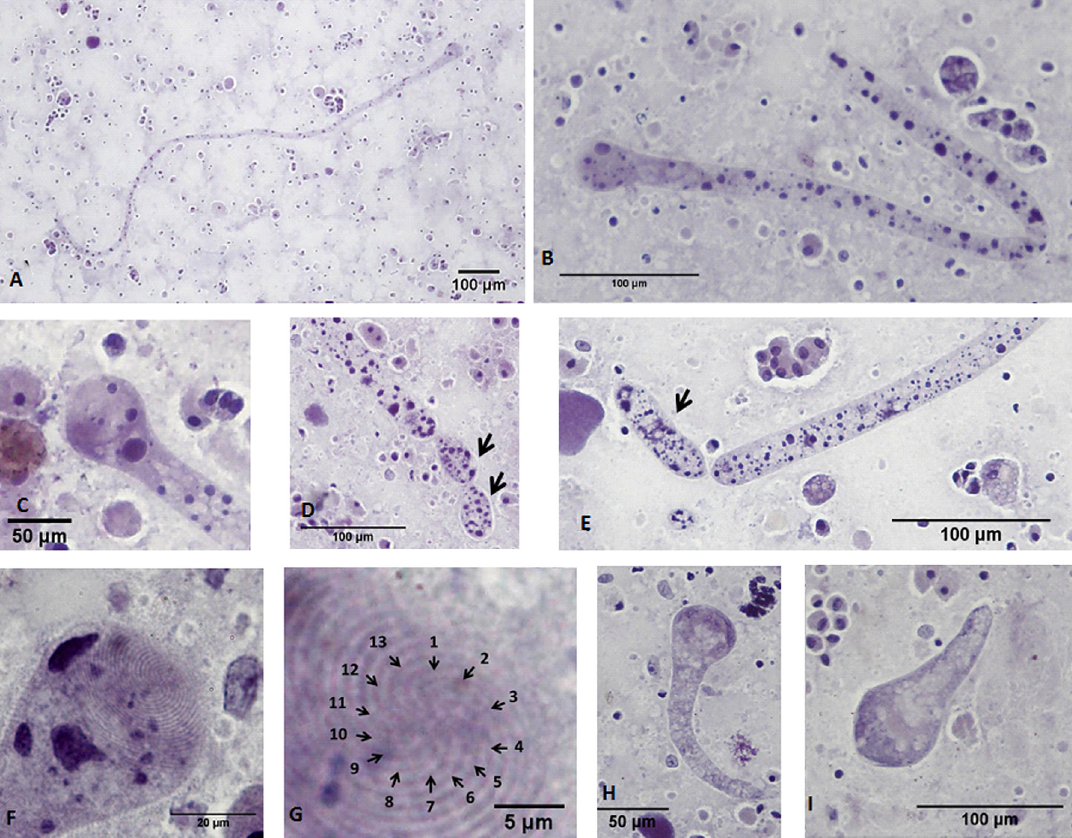
Figure 2. Chromidina chattoni Souidenne, Florent and Grellier n. sp.: morphology. (A, B) General views of tropho-tomonts. (C) Bulb-like head of tropho-tomont. (D, E) Palintomy with first generation of protomites (E) and second generation of protomites (D), arrows: protomites. (F) Bulb-like head of tropho-tomont. Note the presence of large and darkly-stained spots of chromatin associated with the head. (G) Ciliature consisting of 13 kineties (zoom of Fig. 2F). (H–I) Small forms of tropho-tomonts. Images were obtained from smears stained with haematoxylin. (A–I) Hapantotype and